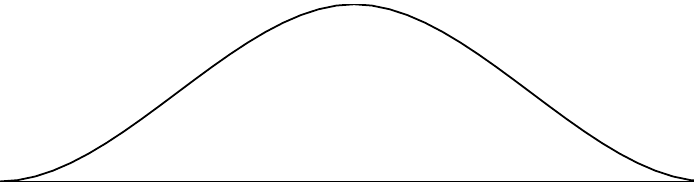
Figure 1. Parcel vertical thickness function (i.e., the outline of a parcel on a level